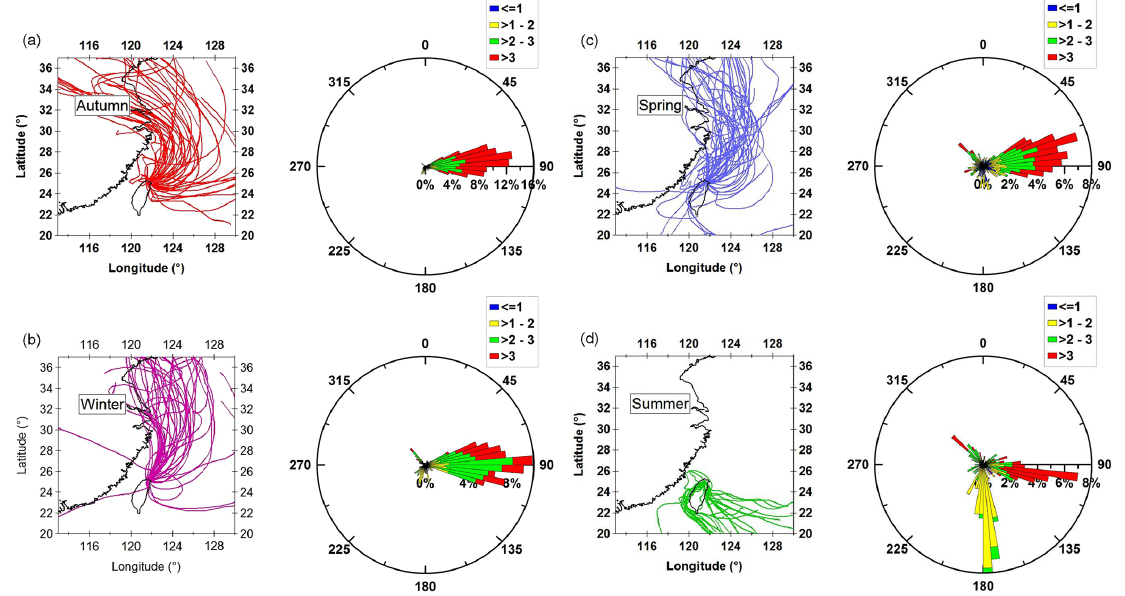
Figure 1. Back trajectories calculated for TARO for the measurement periods (left panel) and surface wind rose plots (right panel) in (a) autumn, (b) winter, (c) spring and (d) summer. The color codes of wind rose plots represent the wind speed: blue < 1ms − 1 ; yellow 1–2ms − 1 ; green 2–3ms − 1 ; red > 3ms − 1